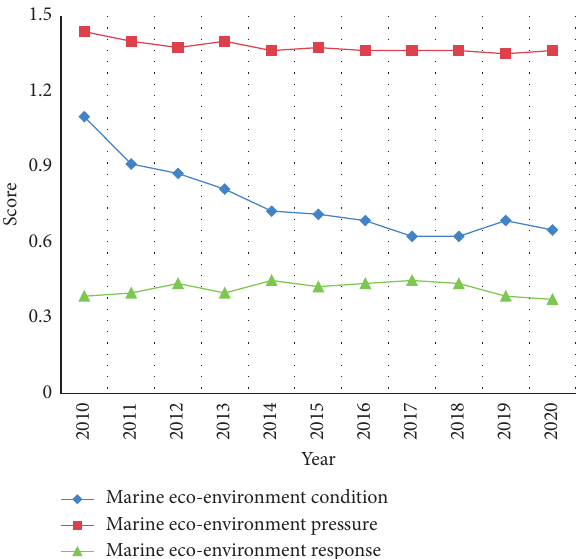
Figure 8: Score of each state layer in the ecoenvironment